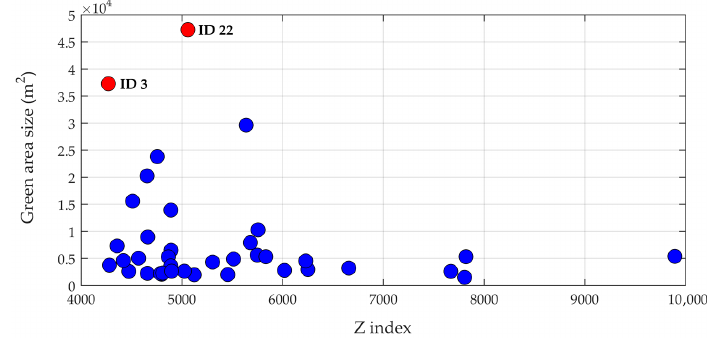
Figure 7. Pareto front obtained through the multi-criteria optimization.